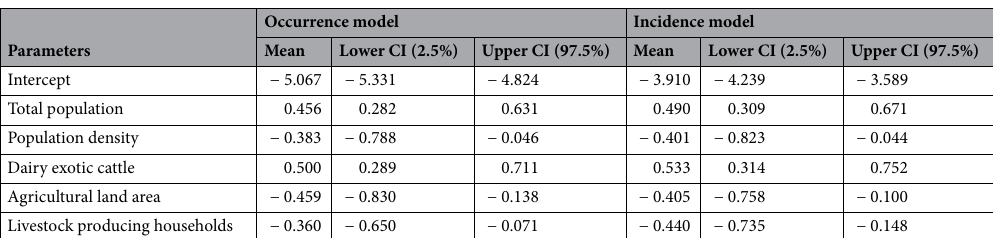
Table 7. The posterior means and the 95% credible intervals for the fixed effects parameters of the covariates in the spatiotemporal occurrence and incidence model.